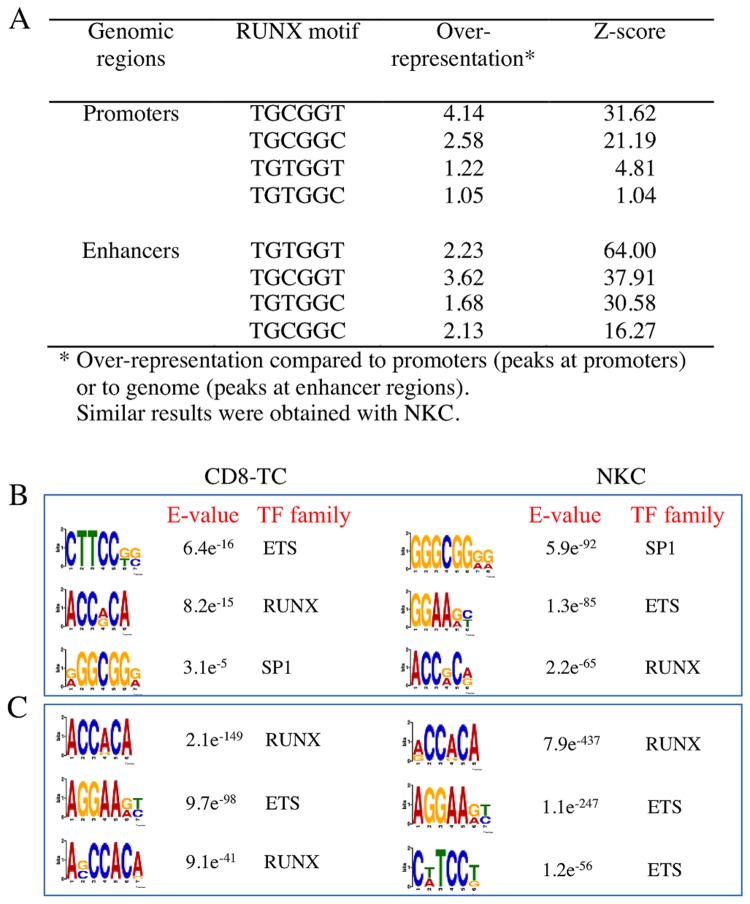
Enriched motifs within Runx3-bound regions in resting cells.(A) Overrepresentation of RUNX motif variants among Runx3-bound regions in CD8-TC. (B and C) Results of de novo motif finding analysis spanning Runx3-bound regions in CD8-TC and NKC. The 3 most enriched motifs in Runx3-bound promoter (B) and enhancer (C) regions are shown.